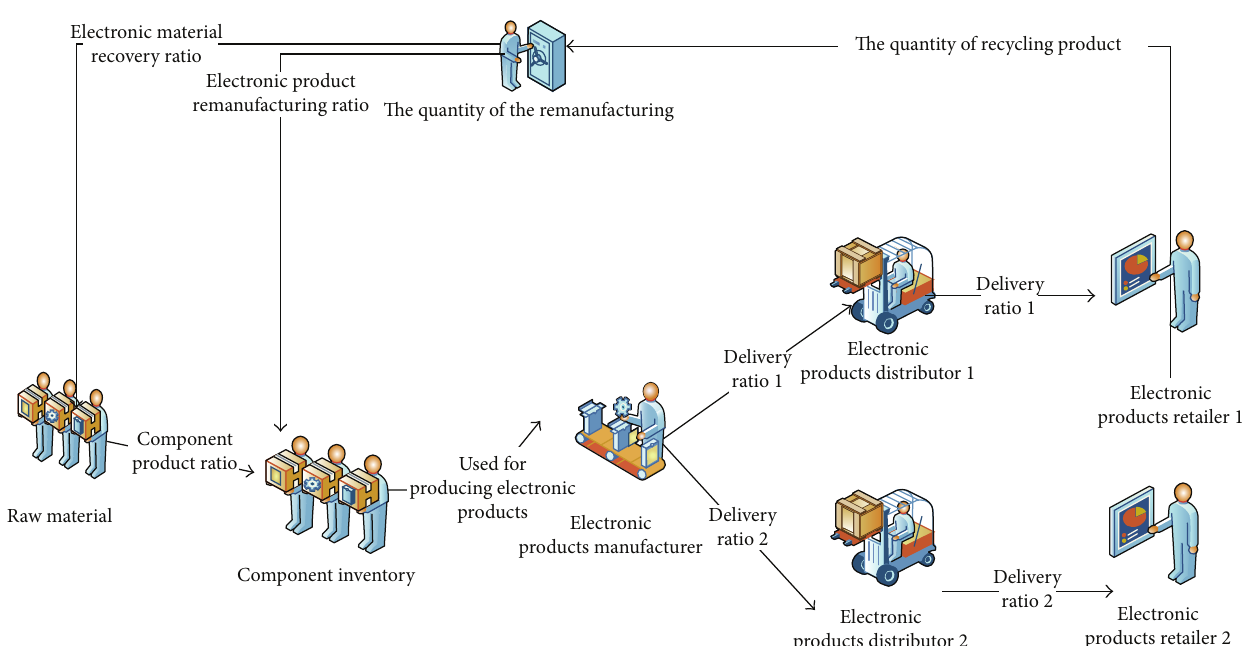
Figure 1: The electronic products closed-loop supply chain distribution network system conceptual